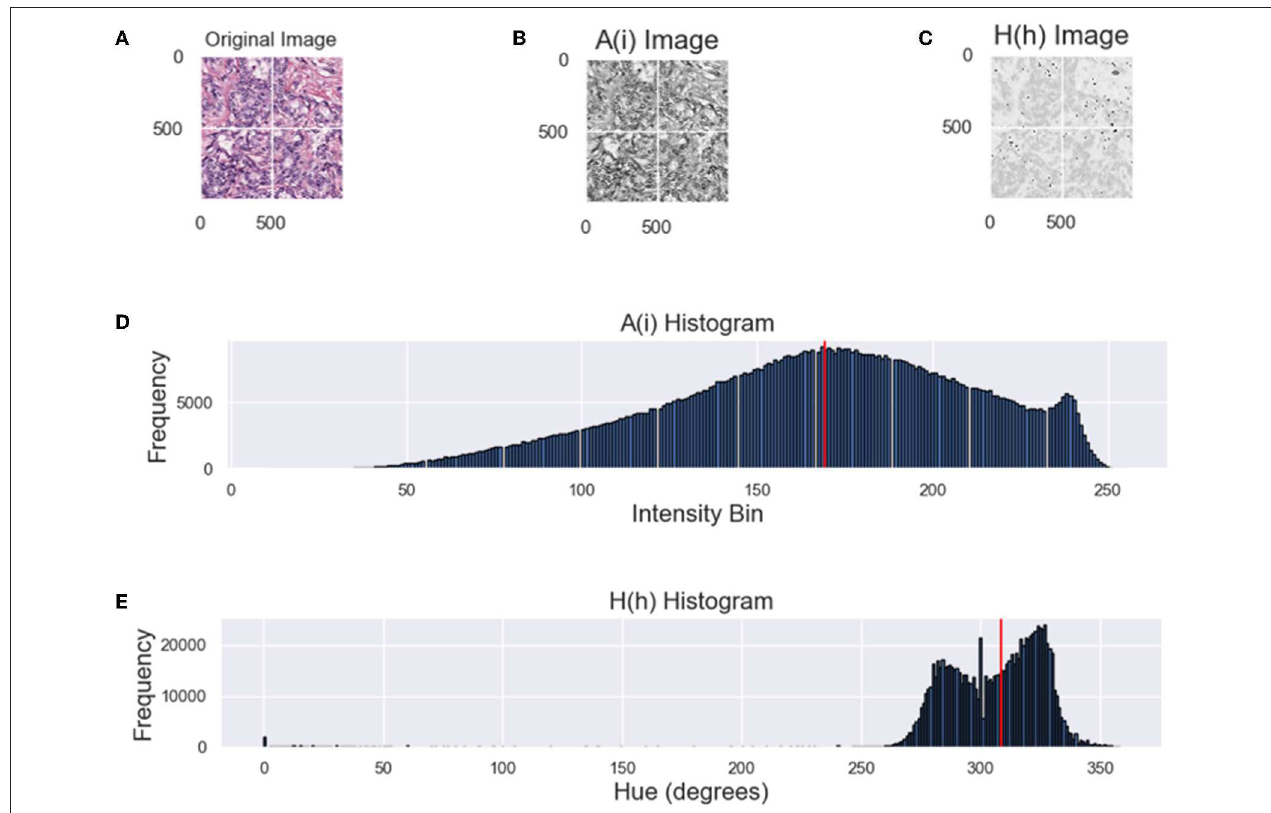
FIGURE 2 | Comparing the NMI and NMH distributions. (A) Original image, (B) A(i)—grayscale image of (A) , (C) hue image (from HSV space), (D) grayscale intensity histogram, (E) hue histogram, where the red line indicates NMI or NMH respectively.